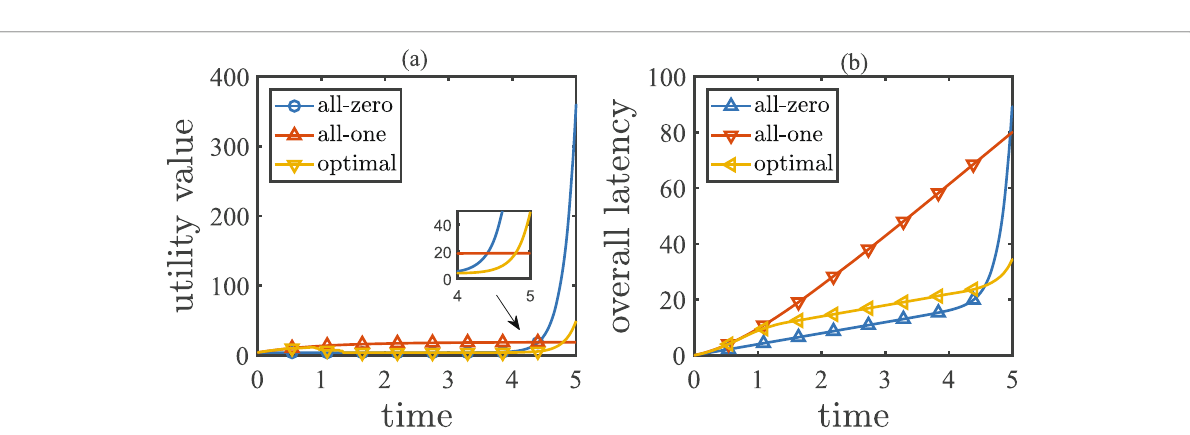
Fig. 10 Performance results of Example 2: (a) the utility function over time; (b) the accumulated overall latency over